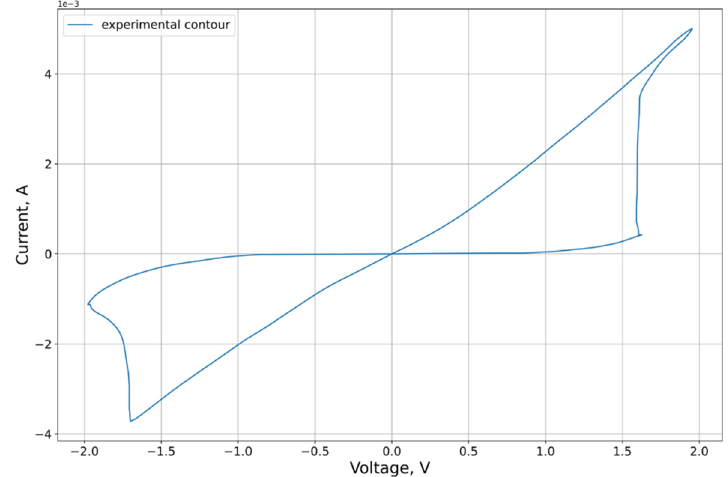
Figure 1. Analyzed sample of the obtained VAC of the memristor structure TiN/Hf x Al 1 − x Oy(6 nm)/HfO 2 (4 nm)/TiN.